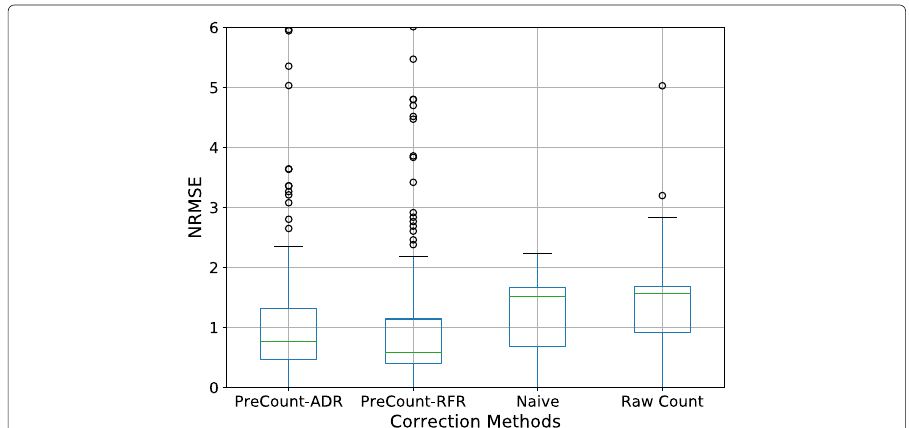
Fig. 6 Boxplot showing the performance of each correction method for UNIVERSITY building case